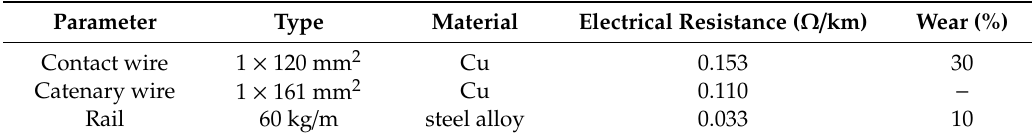
Table A3. Tram supply system input parameters.